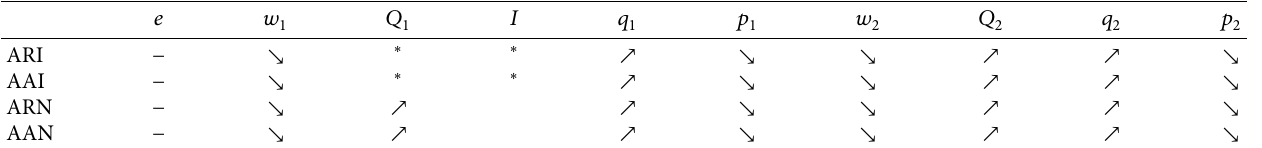
Table 7: Infuence of manufacturers’ altruistic preferences on